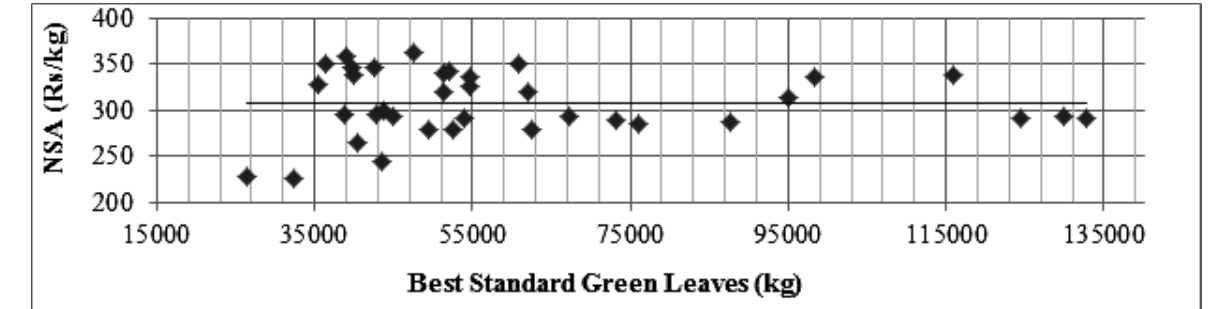
Fig 19: Relationship of Own Leaf Quantity with NSA in Uva